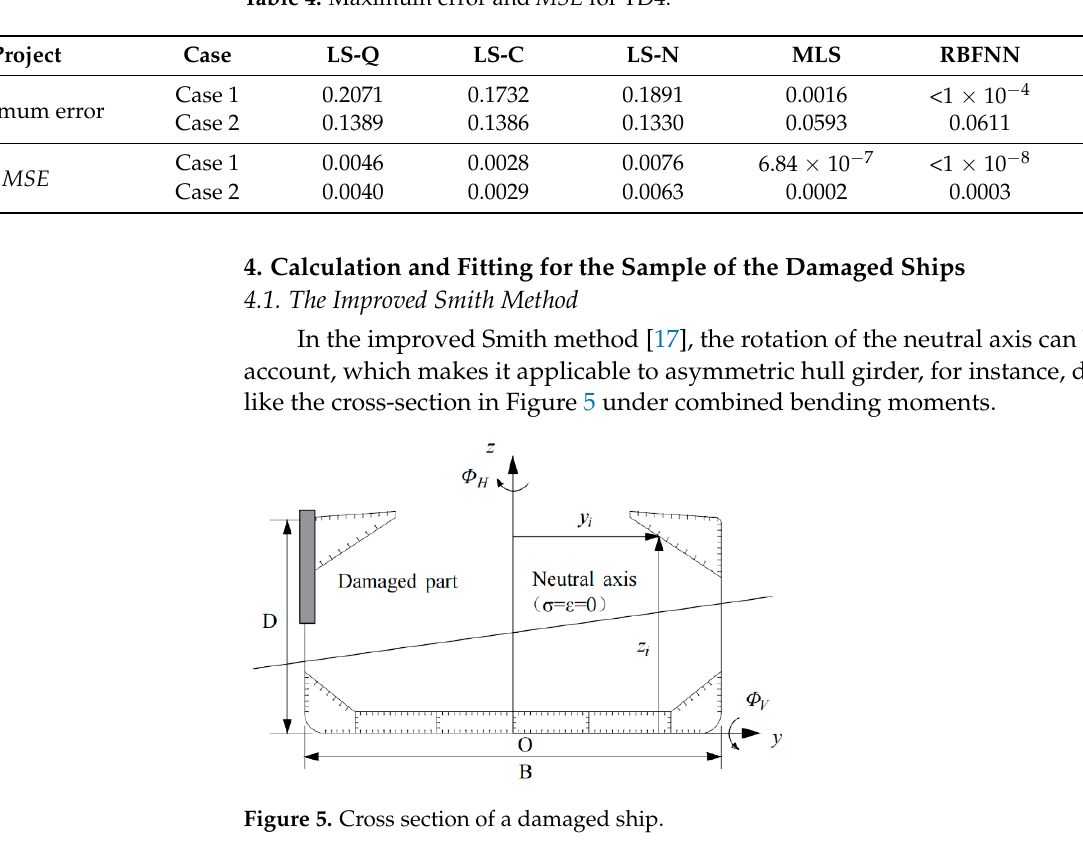
Table 4. Maximum error and MSE for TD4.